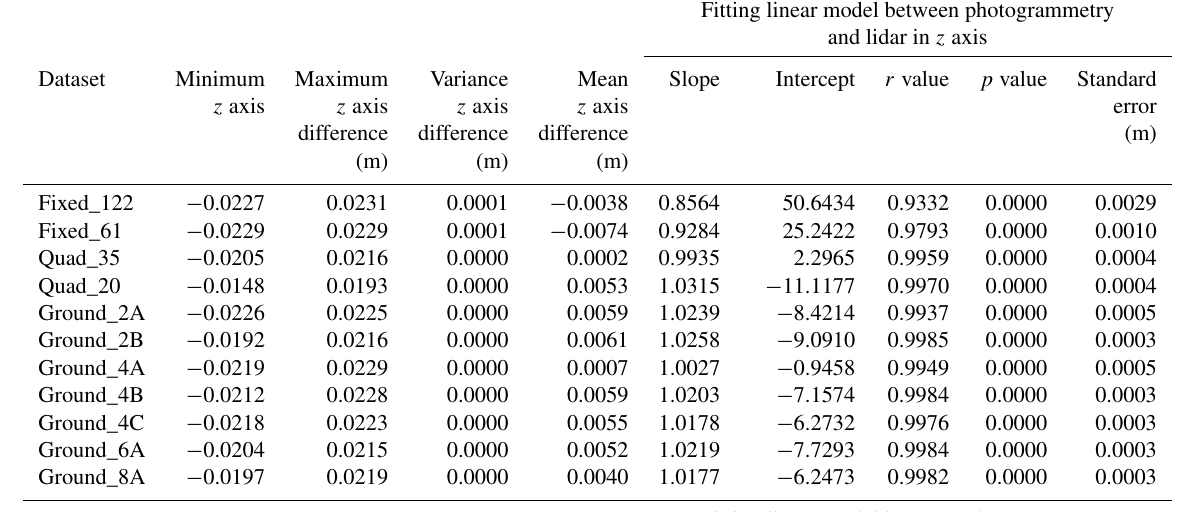
Table 3. Statistics comparing photogrammetry and terrestrial lidar using the point normal projected into the fitted plane analysis. Residual values were calculated based on the coordinate difference of all raster grid